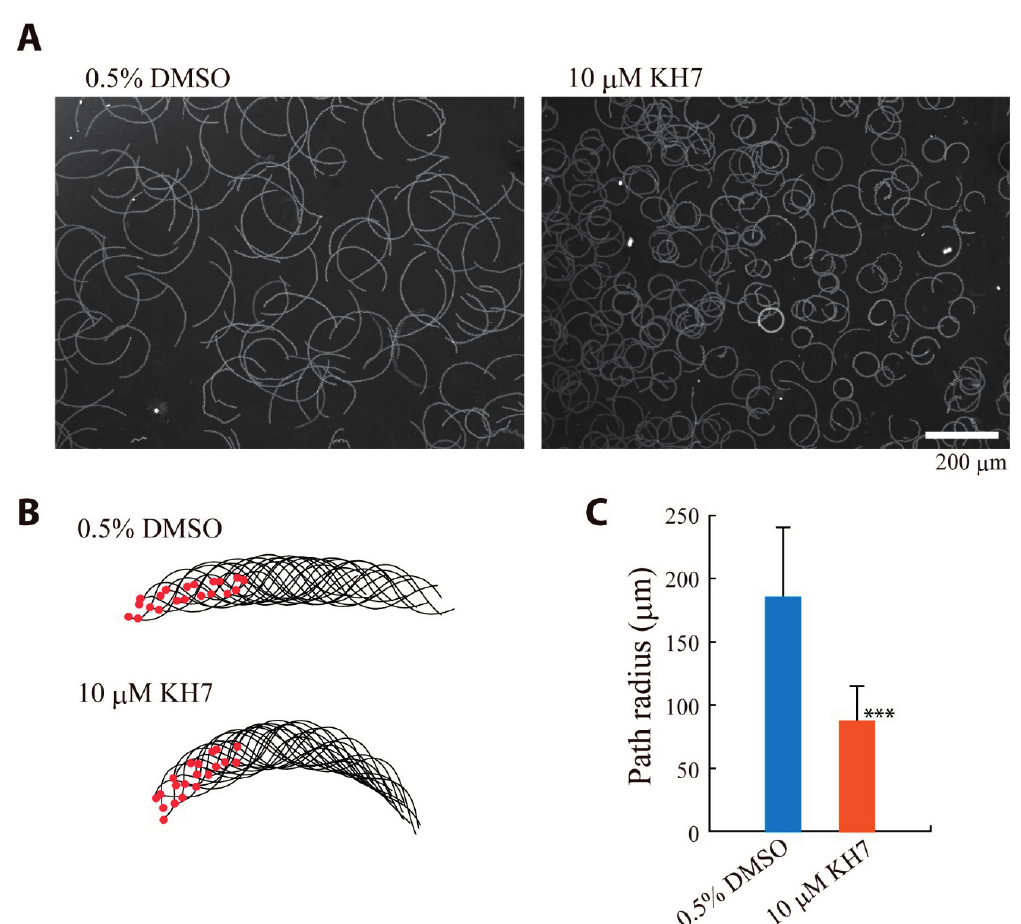
Figure 7. Effects of sAC inhibitor KH-7 on the swimming trajectory and flagellar wave asymmetry of Ciona sperm. ( A ) Swimming trajectories during 1 sec of sperm treated with 0.5% DMSO (control, left ) and sperm treated with 10 μ M KH-7 ( right ). Sperm were activated by 1 mM theophylline. The photo was integrated from 200 images taken at 200 fps; ( B ) Flagellar bending pattern of control or KH-7 treated sperm. Data from 20 waveforms are overwritten. Red dots indicate head position; and ( C ) Diameter of the circle of sperm trajectory in the presence of DMSO (control) or KH-7. Values are means ± SD. n = 120 (control) and 128 (KH-7). *** Significant at p < 0.001 (Student’s t -test) as compared with the